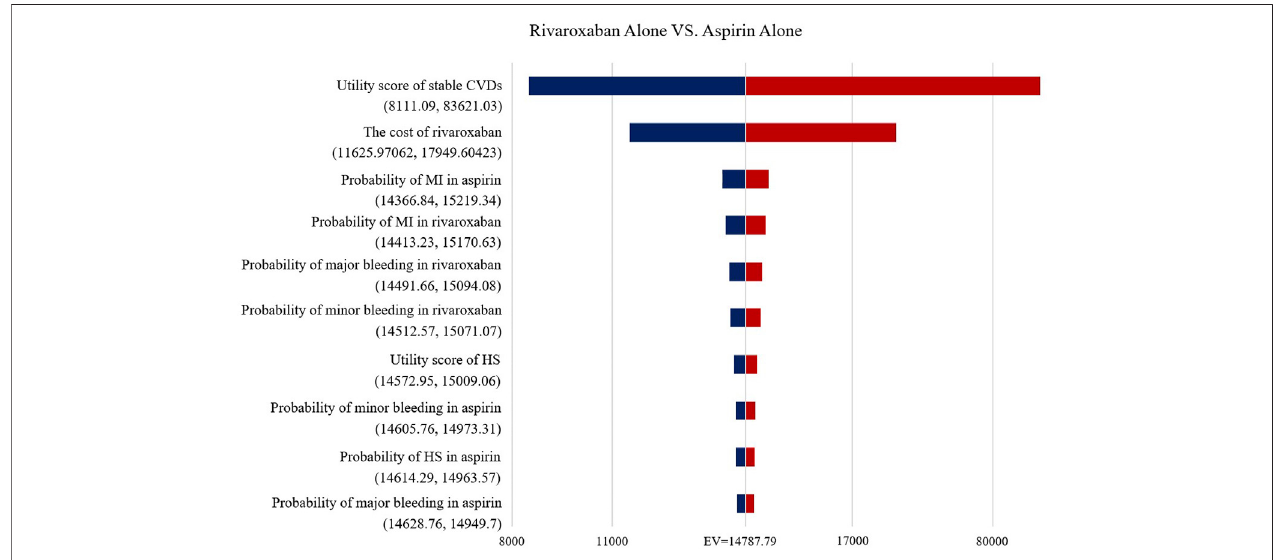
FIGURE 3 | Tornado diagram showing the deterministic sensitivity analysis of the Markov model simulation (Rivaroxaban alone group vs. Aspirin alone